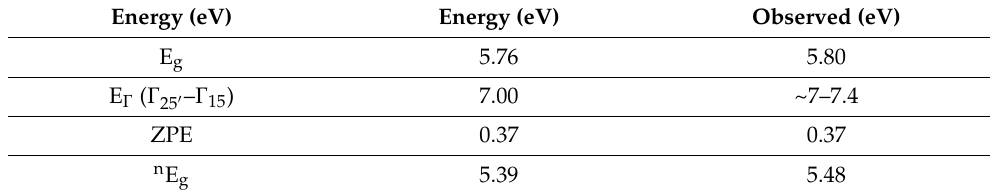
Table 2. B3LYP/6-21G band gap energies E g and E Γ , ZPE, n E g and F g for diamond. Energy